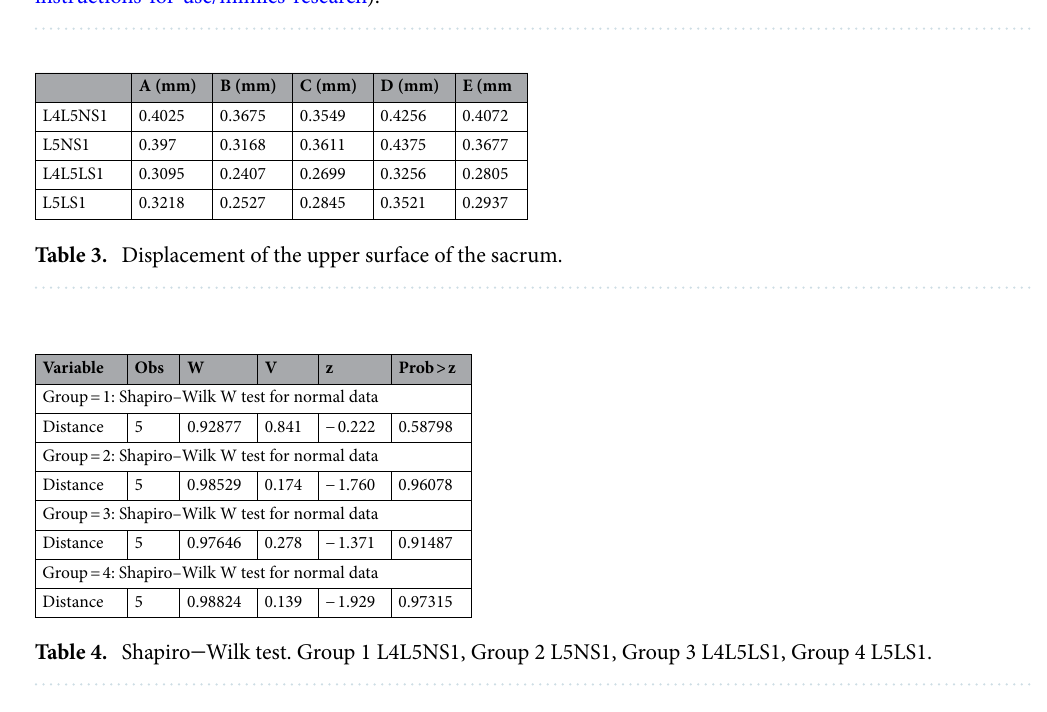
Figure 7. Sketch map of L5LS1 (created by Mimics17.0 https:// www. mater ialise. com/ en/ healt hcare/ elect ronic- instr uctio ns- for- use/ mimics- resea rch).